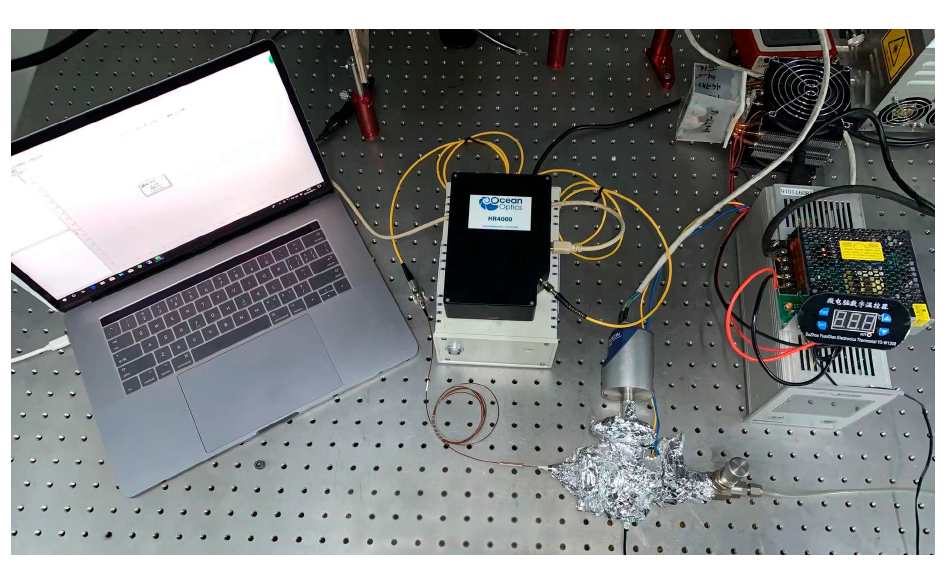
Figure 9. Experimental setup.